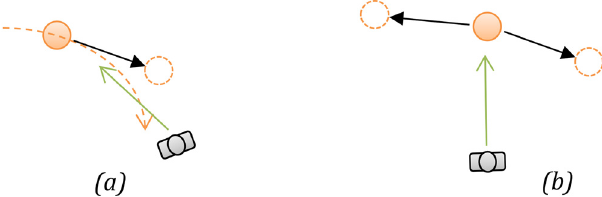
Figure 4: The problems with the position forwarding prediction model. ( a ) Obstacle moves along a curve; ( b ) Obstacle is uncertain about its